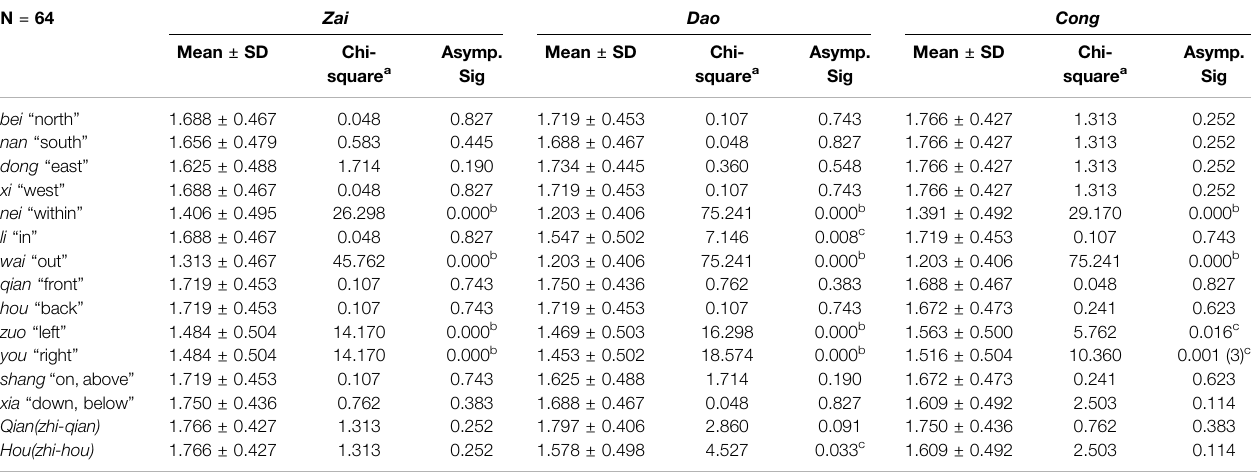
TABLE 2 | The acceptance rates of sentences including localisers referring to locations, divided per preposition type ( zai , dao , and cong ). N = 64